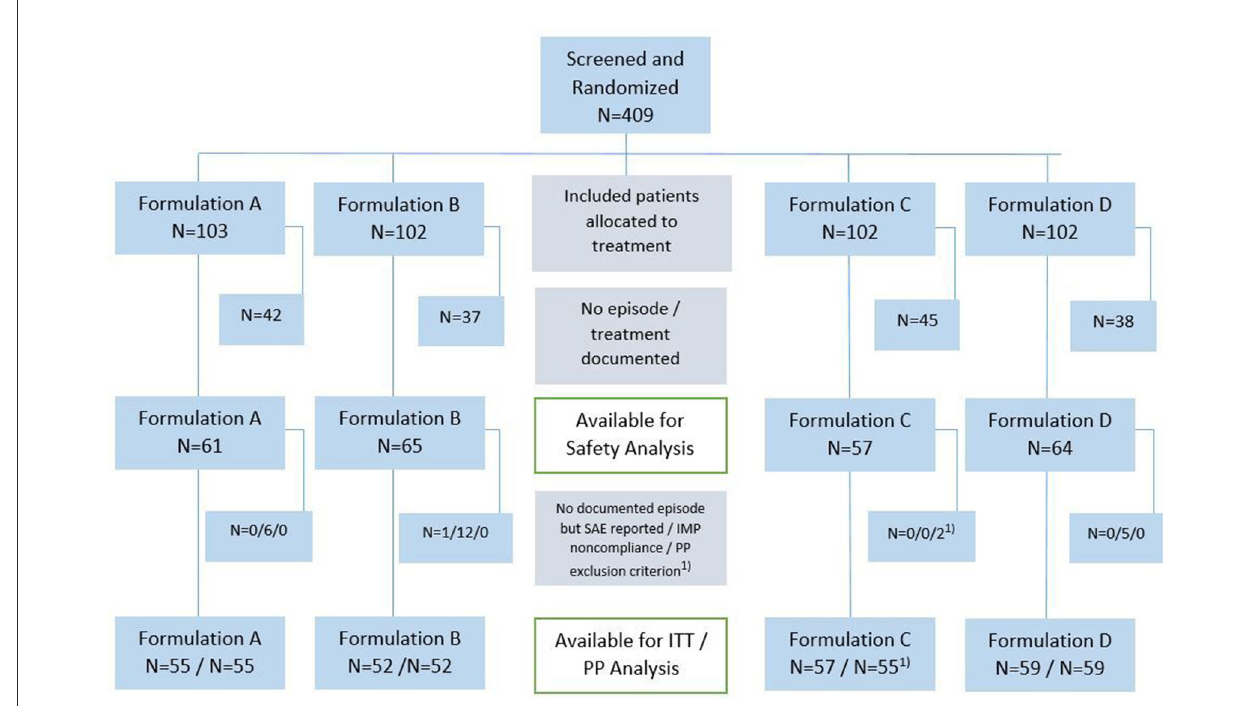
FIGURE1 Study flow diagram. Number of patients are shown in both, PP and ITT populations; formulation A, lozenges; formulation B, spray; formulation C, conventional tablets; formulation D, conventional drops; RTI, respiratory tract infection; SAE, severe adverse event. 1 Two patients were excluded from PP analysis due to seriously delayed follow-up phone call and medication of obstructive airways disease (exclusion